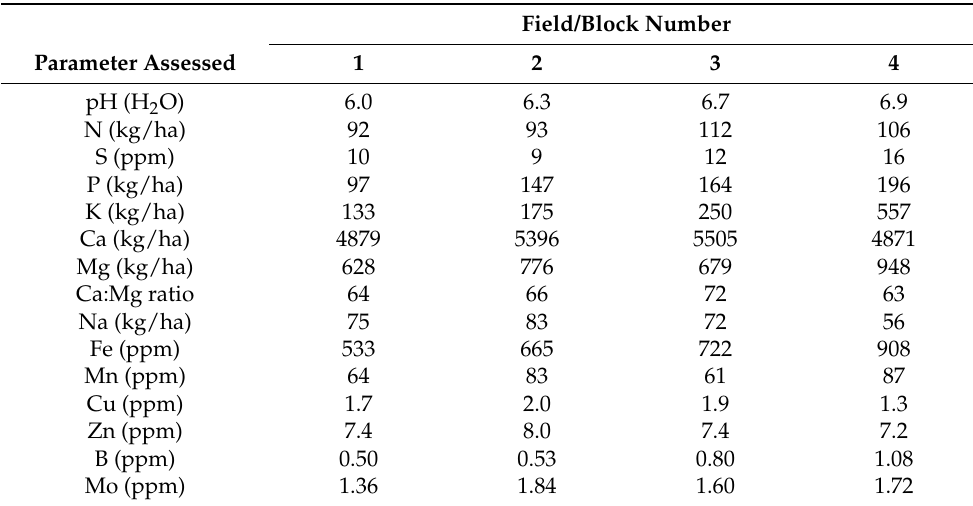
Table 1. Results of soil analysis carried for the 4 fields used as blocks/replicates carried out before the start of the experiment in